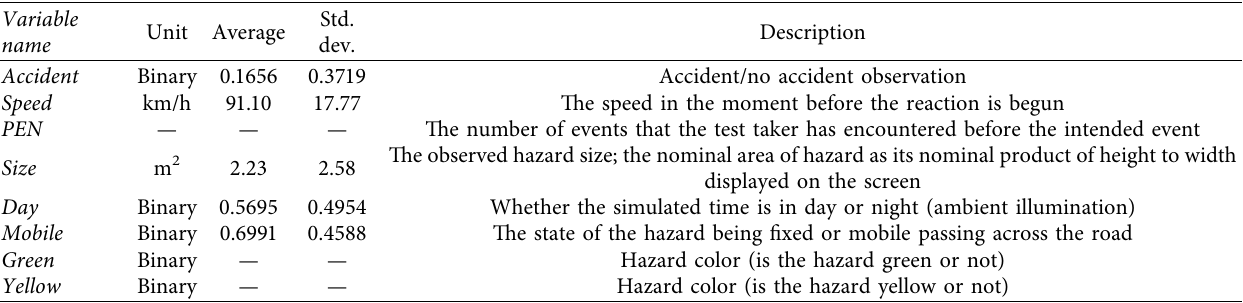
Table 2: Variable used in the modelling.